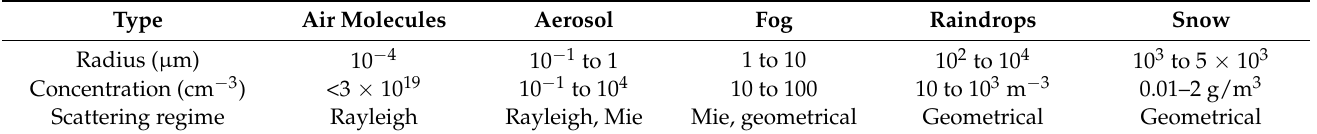
Table 2. Typical atmospheric scattering phenomena.